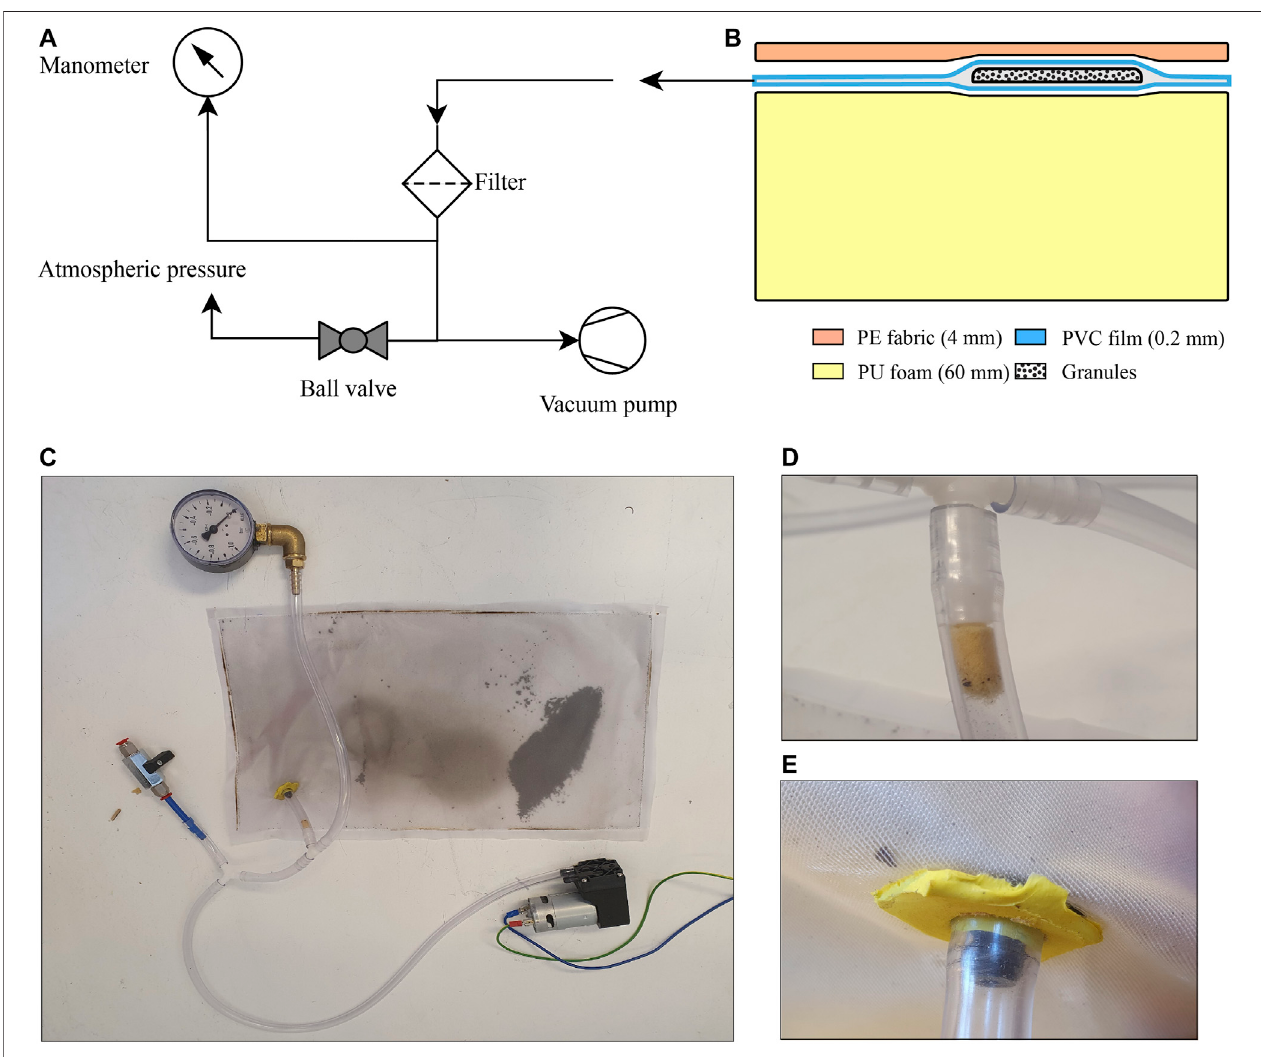
(cid:129) C3: Hard Lump. A circular-shaped irregularity rendered with the magnet con fi guration seen in Figure 5B . Vacuum level: 0.4 to − 0.6 bar. Located in the top right part of the fi eld. Approximately 100 mm diameter with area M (cid:1) 7,912 mm 2 SD (cid:1) 474 mm 2 SE (cid:1) 89 mm 2 . (cid:129) C4: Soft Lump. A circular-shaped irregularity rendered with the magnet con fi guration seen in Figure 5C . Vacuum level: 0.1 bar. Located in the top right part of the fi eld. Approximately 100 mm diameter with area M (cid:1) 8,094 mm 2 SD (cid:1) 641 mm 2 SE (cid:1) 121 mm 2 . The sequence of the testing conditions was randomized to avoid potential learning or order effects. The order of conditions was also balanced, i.e., they appear the same number of times in each procedure